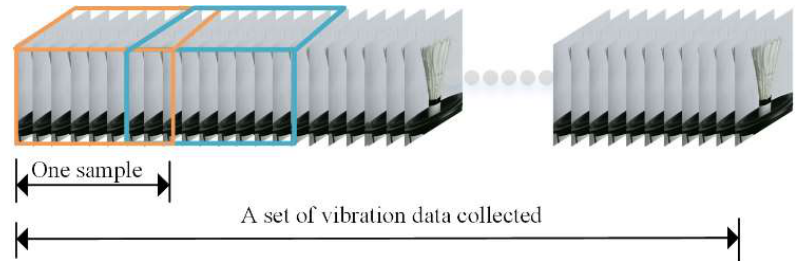
Figure 8. Data augment and preparation.